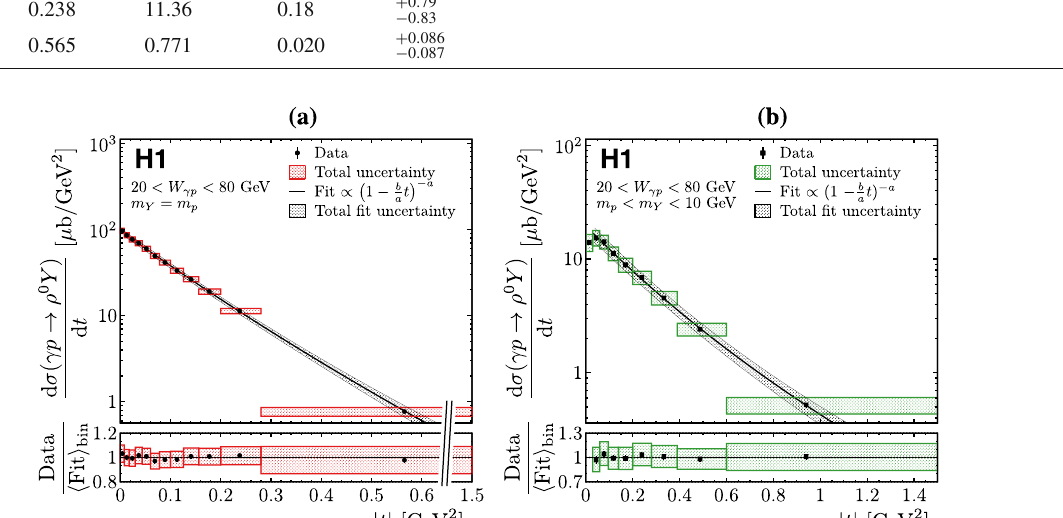
Fig. 14 Elastic ( m Y = m p ) ( a ) and proton-dissociative ( m p < m Y < 10 GeV) ( b ) differential ρ 0 meson photoproduction cross sections d σ(γ p → ρ 0 Y )/ d t as functions of t . The distributions are parametrised with fits as described in the text, and the fitted curves